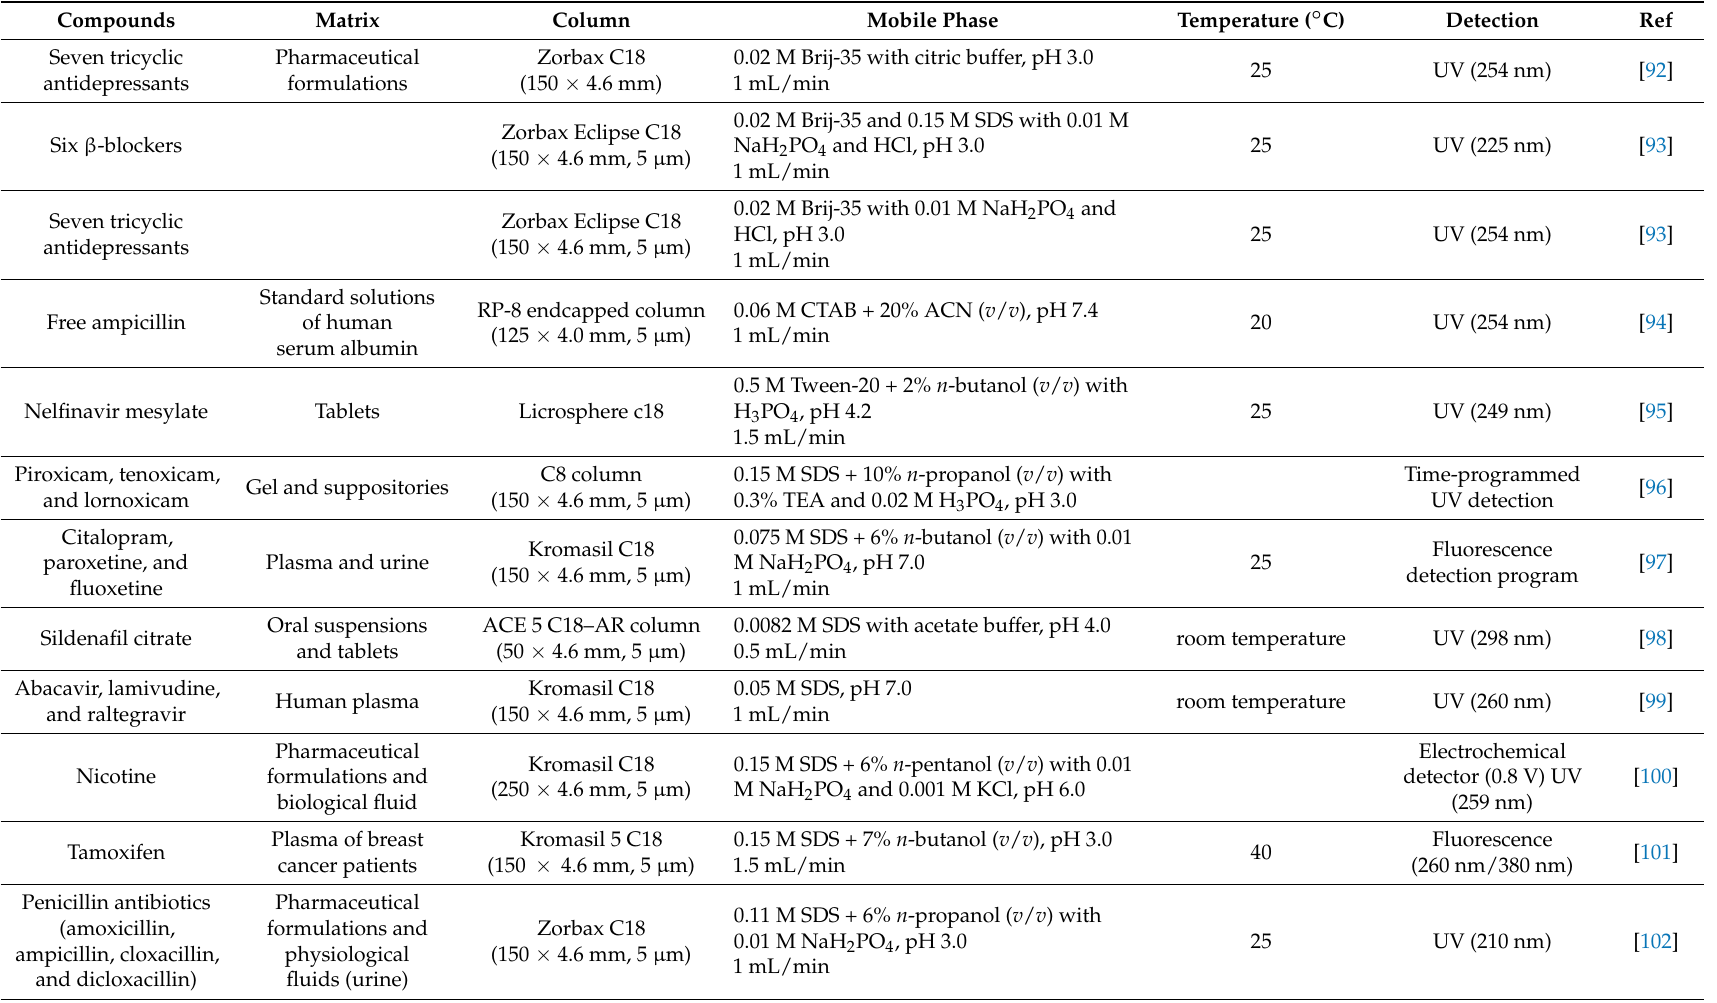
Table 2. Some recent applications of MLC in pharmaceutical